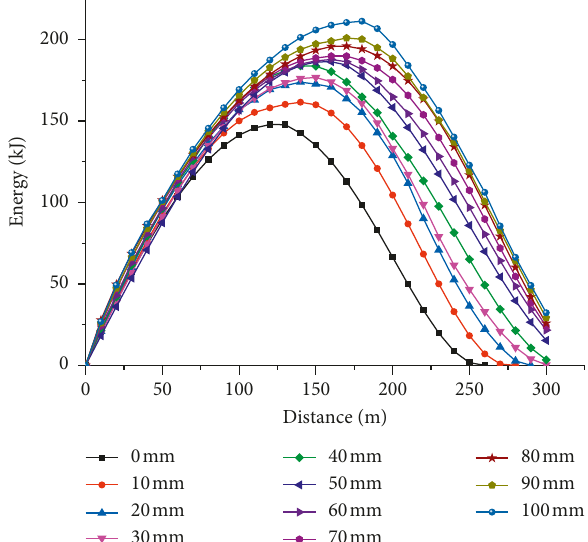
Figure 16: Changing curve of kinetic energy with different vent diameters.